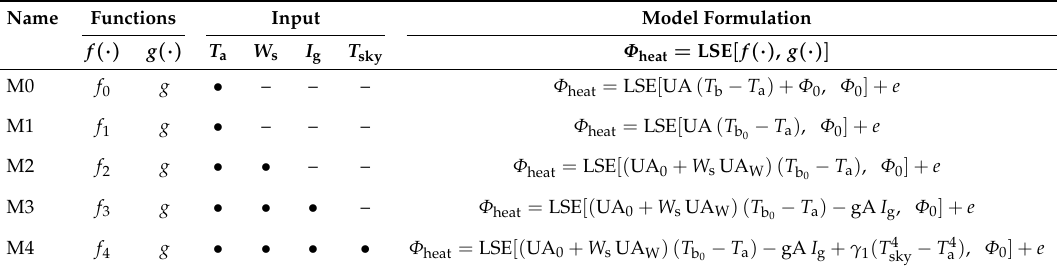
Table 1. Overview of full models. The model names are stated in the leftmost column as M0, M1 up to M4. The bullets ( • ) indicate if the given inputs are included in the specific model. Model M0 distinguishes itself from the remaining models, as the base temperature T b is fixed at 17 ◦